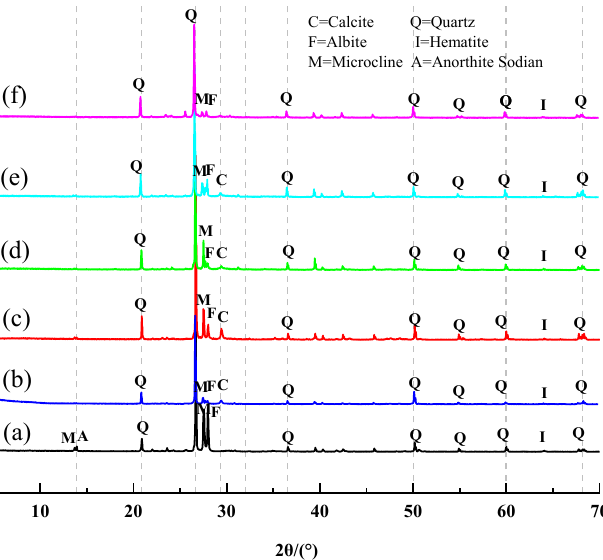
Figure 8. X-ray diffraction patterns of Xiaoluan River sediment and sediment geopolymer composites. (a) Xiaoluan River sediment, (b) A3: Ratio of SiO 2 to Na 2 O in the sodium silicate solution is 2.0, (c) B3: Quicklime = 8 wt.%, (d) D1: Slag = 10 wt.%, (e) D2: Fly ash = 10 wt.%, (f) D3: Silica fume = 10 wt.%.